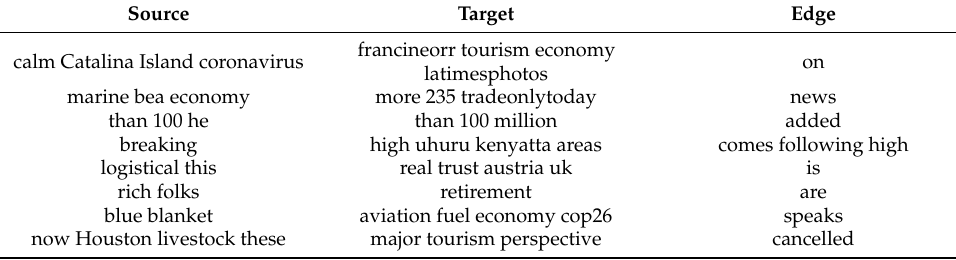
Table 7. Cluster wise Entity Relation Extraction – 2 .